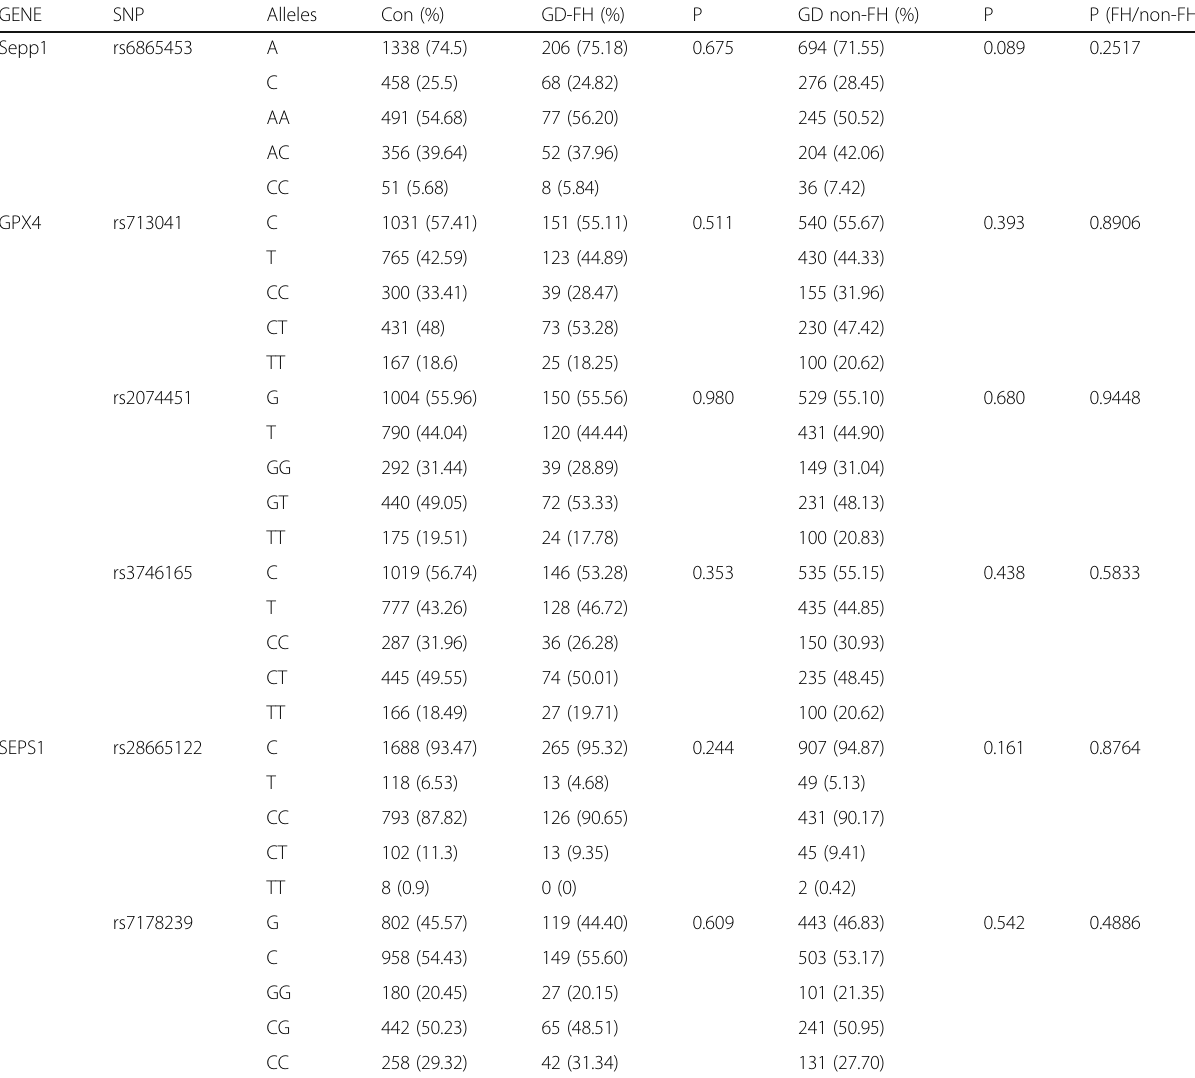
Table 6 Allele and genotype frequencies in GD patients with or without family history and controls GENE SNP